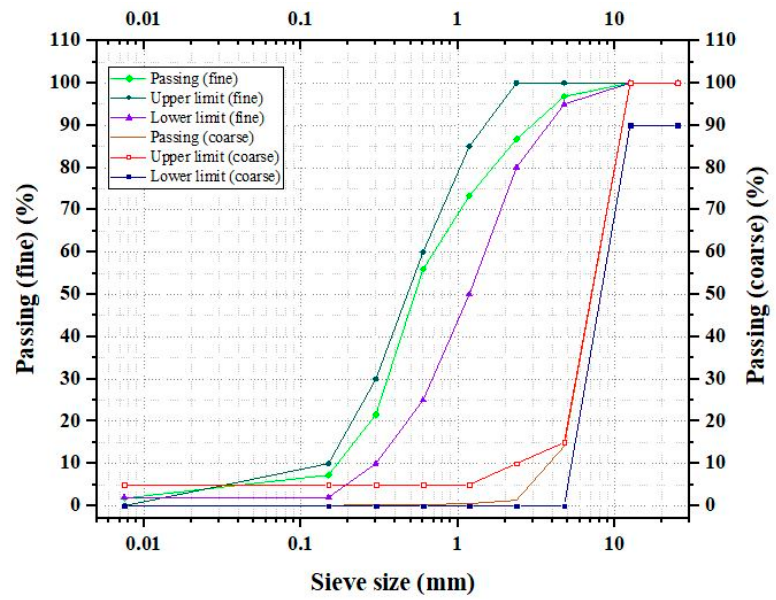
Figure 2. Aggregates’ size distribution.